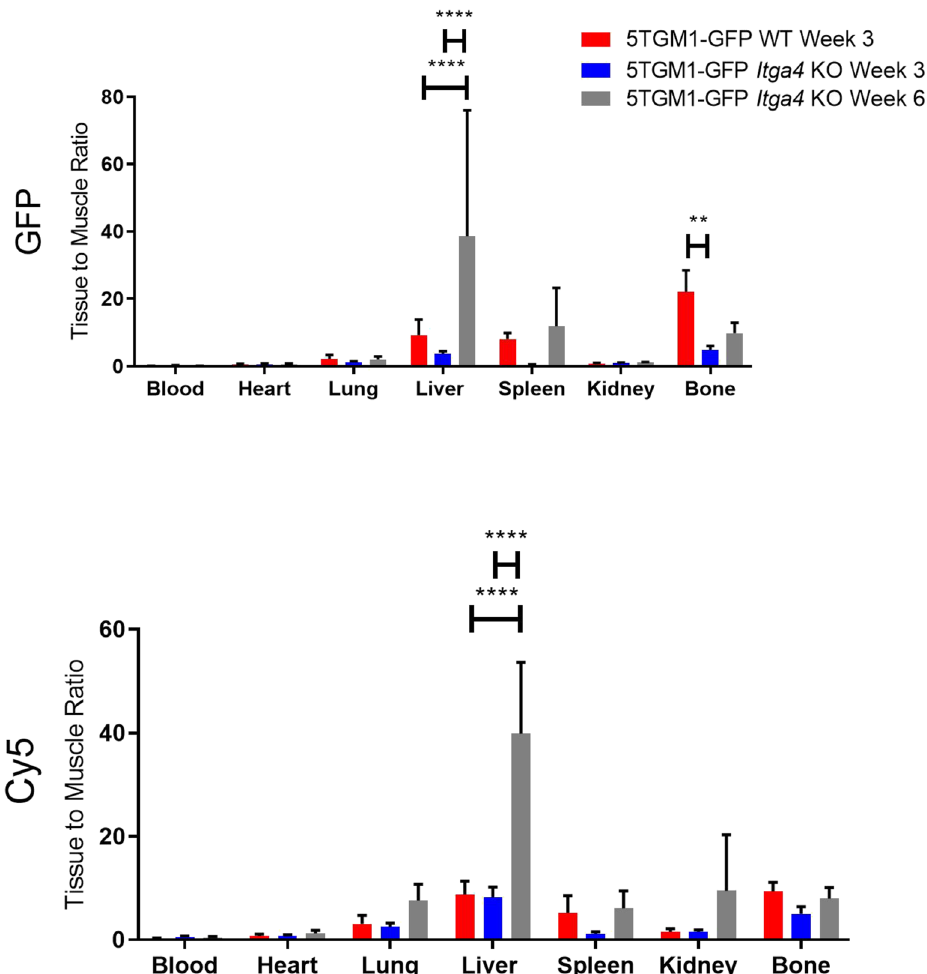
Figure 7. LLP2A-Cy5 NIR imaging of C57Bl/6 KaLwRij mice injected with 5TGM1-GFP WT and KO cells. Normalized biodistribution [defined as tissue to muscle ratio (TMR)] of GFP and Cy5 three and six weeks post-administration of cells. Two-way ANOVA followed by Sidak’s multiple comparisons test was performed on biodistribution data (** p < 0.01; **** p <